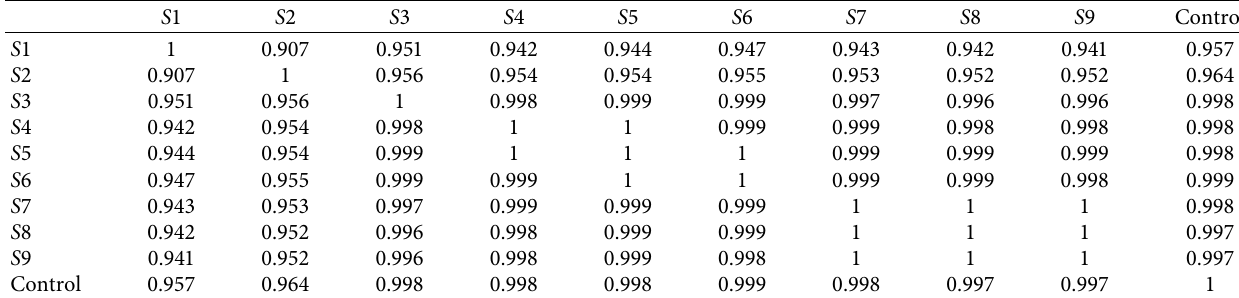
Table 6: Sample similarity analysis.